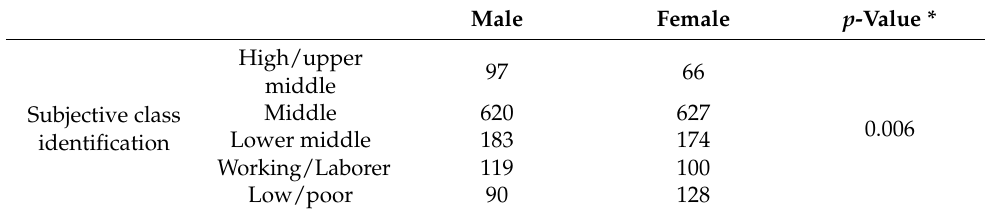
Table 2. RotatedComponentMatrixofthevariable“Emotionalfearscausedbythecoronaviruspandemic”. Fear of becoming ill